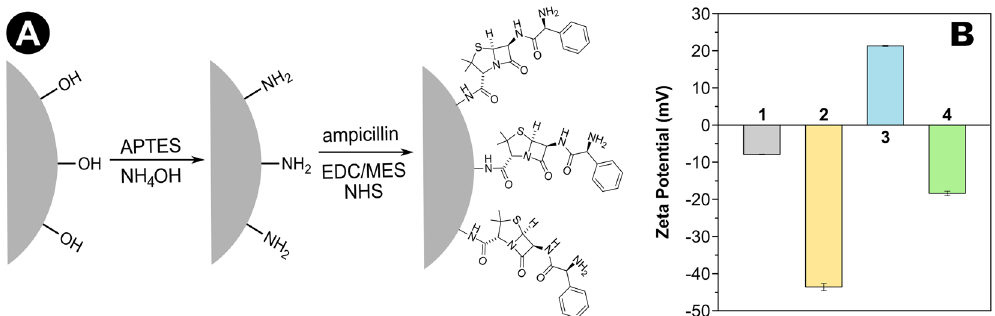
Figure 3. ( A ) Reaction steps to obtain nanoparticles functionalized with ampicillin. First, nanoparticles are coated with amino groups on the surface and the amino-functionalized nanoparticles react with the carboxyl groups of ampicillin through an acid-base coupling reaction to form Ag@SiO 2 -Ampicillin. This scheme is merely illustrative and is not in proportion to the actual size of the system. ( B ) Zeta potentials for (1) AgNP, (2) Ag@SiO 2 , (3) Ag@SiO 2 -NH 2 and (4) Ag@SiO 2 -Ampicillin.